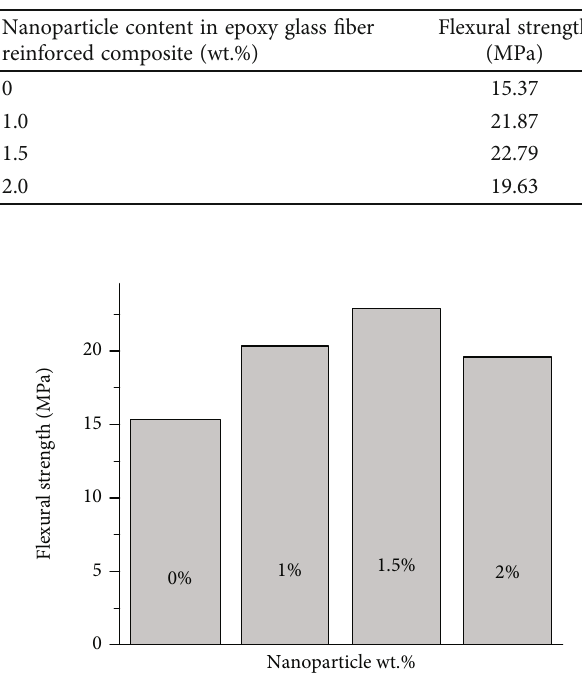
Figure 6: Flexural strength of the epoxy nanocomposites. Table 3: Impact properties of nanoparticle reinforced epoxy composites. Nano particle content in epoxy glass fi ber reinforced composite (wt.%)